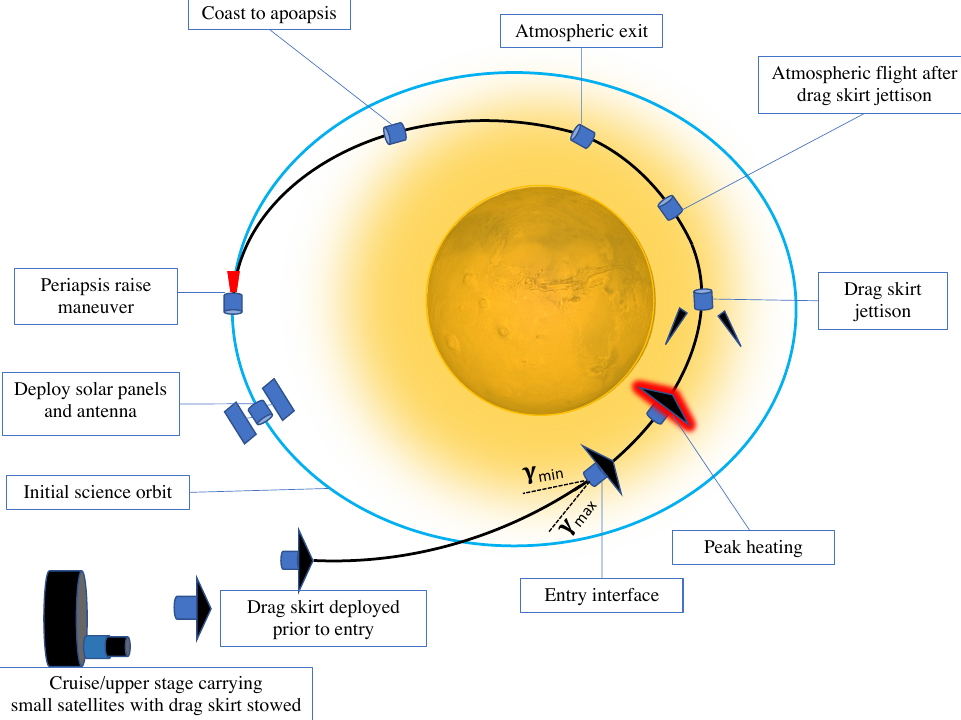
Figure 3. Schematic showing the key events in drag-modulation aerocapture for small satellite orbit insertion. Distances are not to scale, and atmospheric extent is greatly exaggerated for